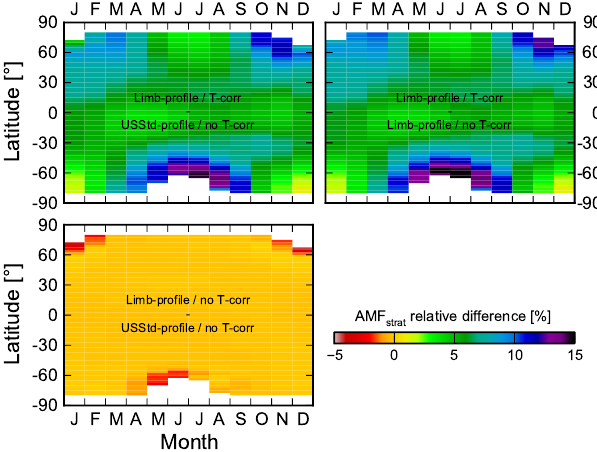
Fig. 16. Monthly climatologies of the influence of stratospheric NO 2 profiles and temperature correction on stratospheric air mass factors. The plots show the influence of both profiles and temper- ature correction (top left), temperature correction alone (top right), and vertical profiles alone (bottom left). The climatologies are cal- culated for the years 2003–2010, using all retrieved limb profiles from the descending part of the SCIAMACHY orbit. The influ- ence of the vertical profile is derived by comparing to using the US Standard Atmosphere’s NO 2 profile. Stratospheric temperature pro- files are taken from the ECMWF forecast (the same profiles used in the limb retrieval). The geometric line-of-sight correction (the sum- − 1) has been ignored in this comparison, and the relative mand 1 cos α . difference of two datasets is computed as a − b (a + b)/ 2